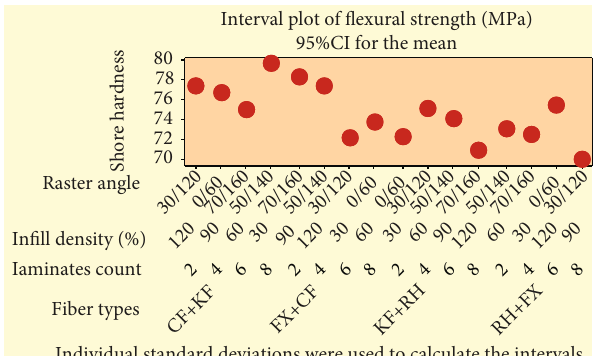
Figure 13: Interval plot of shore hardness.